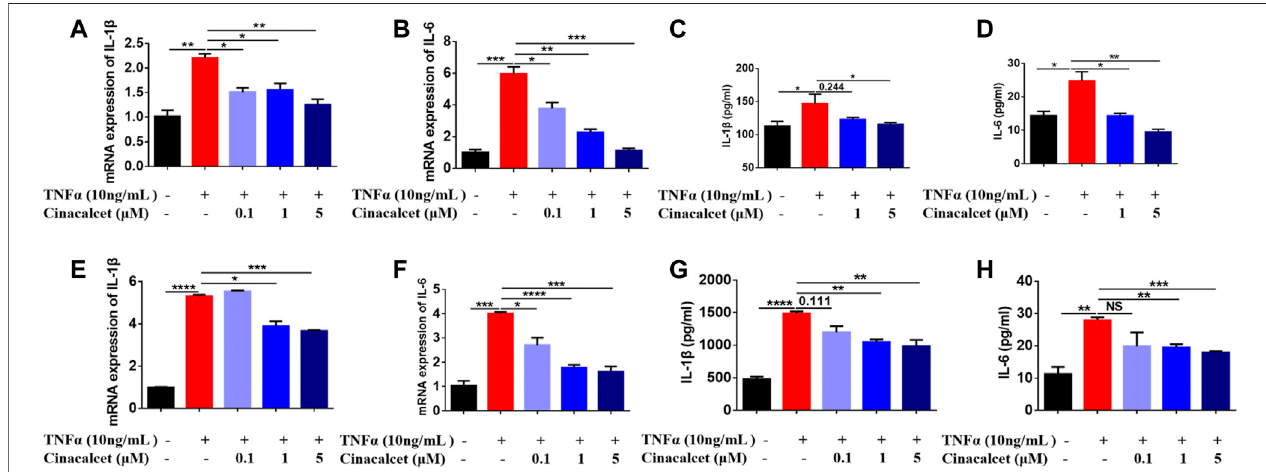
FIGURE 1 | Cinacalcet inhibits the production of cytokines induced by TNF α . Bone marrow-derived macrophages (BMDMs) or RAW264.7 cells were treated with TNF α (10 ng/ml)intheabsenceorpresence ofcinacalcet (0.1,1,5 μ M)for24 h.mRNAexpression levelsof IL-1 β and IL-6 ,normalized totheinternal reference GAPDH , were detected by qRT-PCR. Cytokine levels in the supernatants were detected by ELISA. (A, B) mRNA expression levels of IL-1 β and IL-6 in RAW264.7 cells. (C, D) CytokinelevelsofIL-1 β andIL-6insupernatantsofRAW264.7 cells. (E,F) mRNAexpression levelsof IL-1 β and IL-6 inBMDMs. (G,H) Cytokinelevels ofIL-1 β